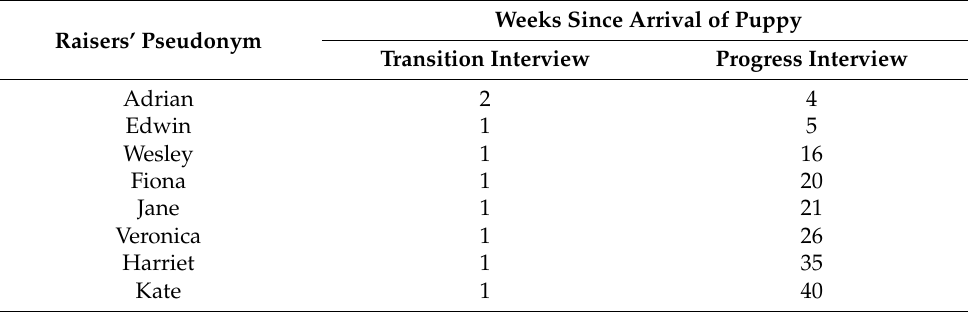
Table 1. Length in the program at the time of interviews included in data analysis. Weeks Since Arrival of Raisers’ Pseudonym